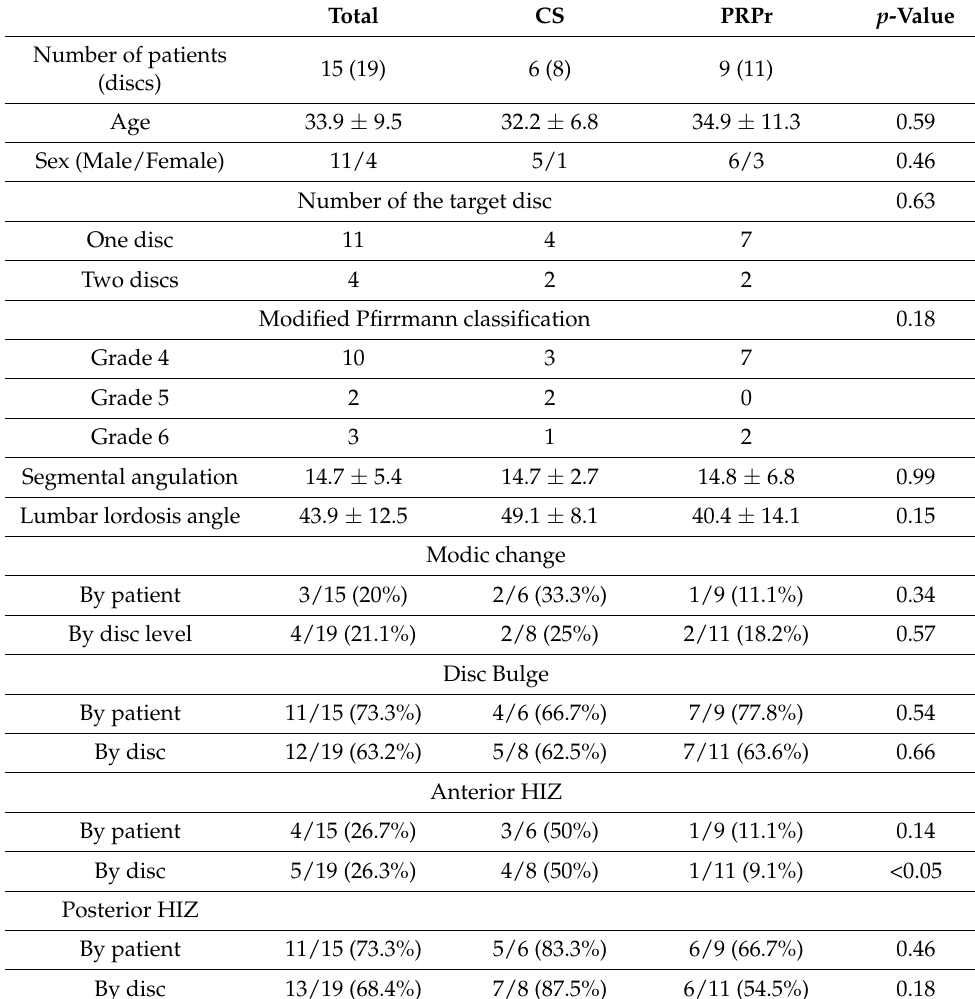
Table 1. Patient’s baseline